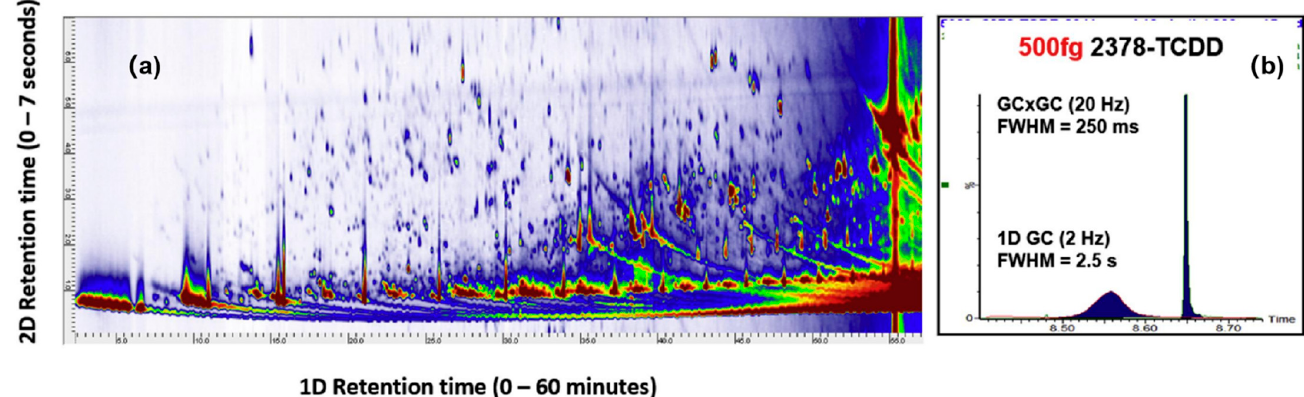
Figure 2. ( a ) Comprehensive two-dimensional gas chromatography (GC × GC) affords unparalleled separation of organic pollutants from in plasma; ( b ) Modulated gas chromatogram obtained from 2,3,7,8-tetrachlorodibenzo- p -dioxin, resulting in 10-fold signal-to-noise (S/N) enhancement. Similar S/N enhancement can be achieved using either thermal or flow modulation. Reprinted from Ref. [80]. Copyright 2020, with permission from Elsevier.